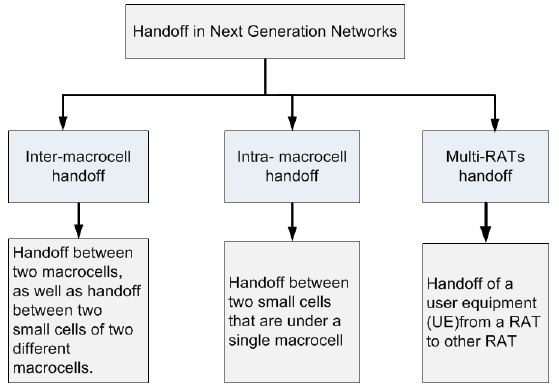
Figure 3. Hand-off in next-generation networks (inspired from